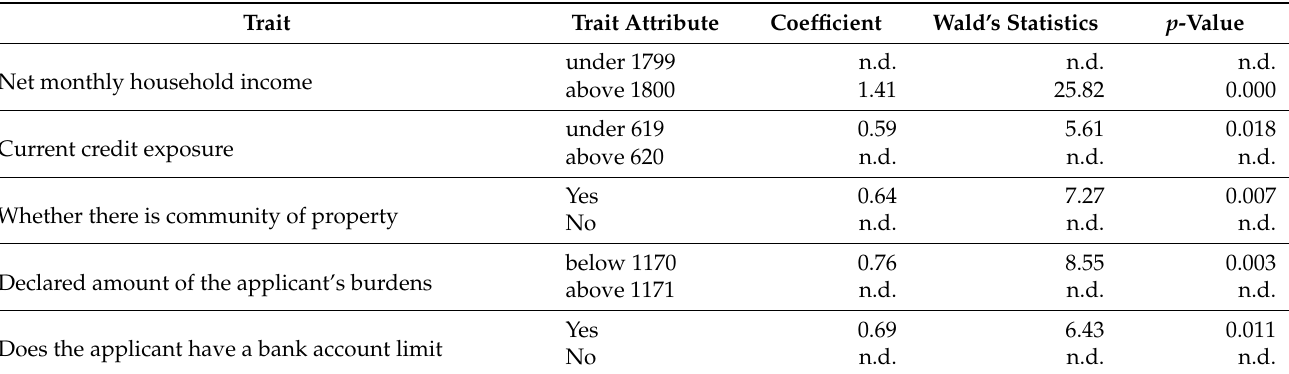
Table 9. Credit risk logit model for Bank